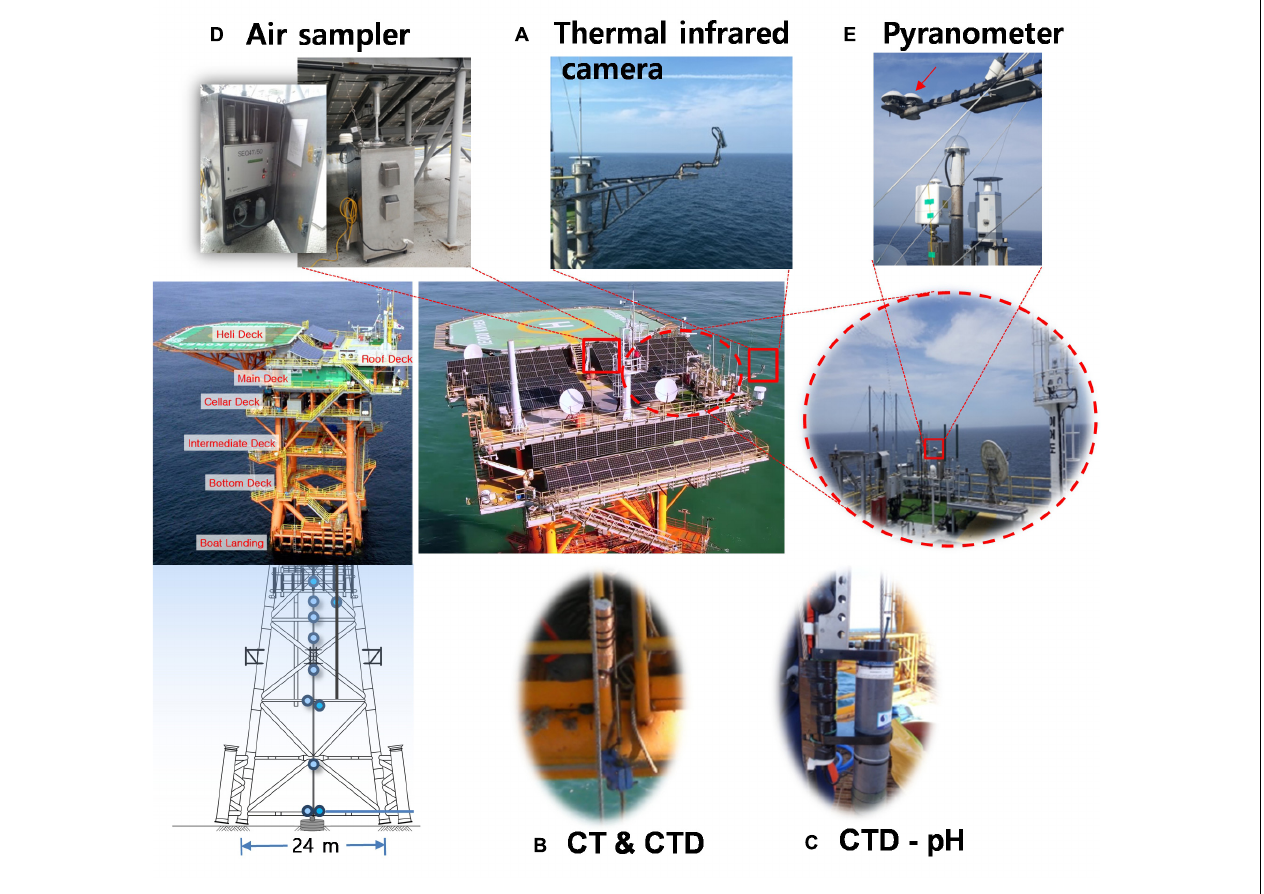
FIGURE 3 | Instruments installed on Ieodo ORS for monitoring ocean and atmospheric environments: including a thermal infrared camera (A) ; conductivity-temperature (CT) and conductivity-temperature-depth (CTD) sensors (B) ; CTD-pH sensor (C) ; air sampler (D) ; and pyranometer (E) .